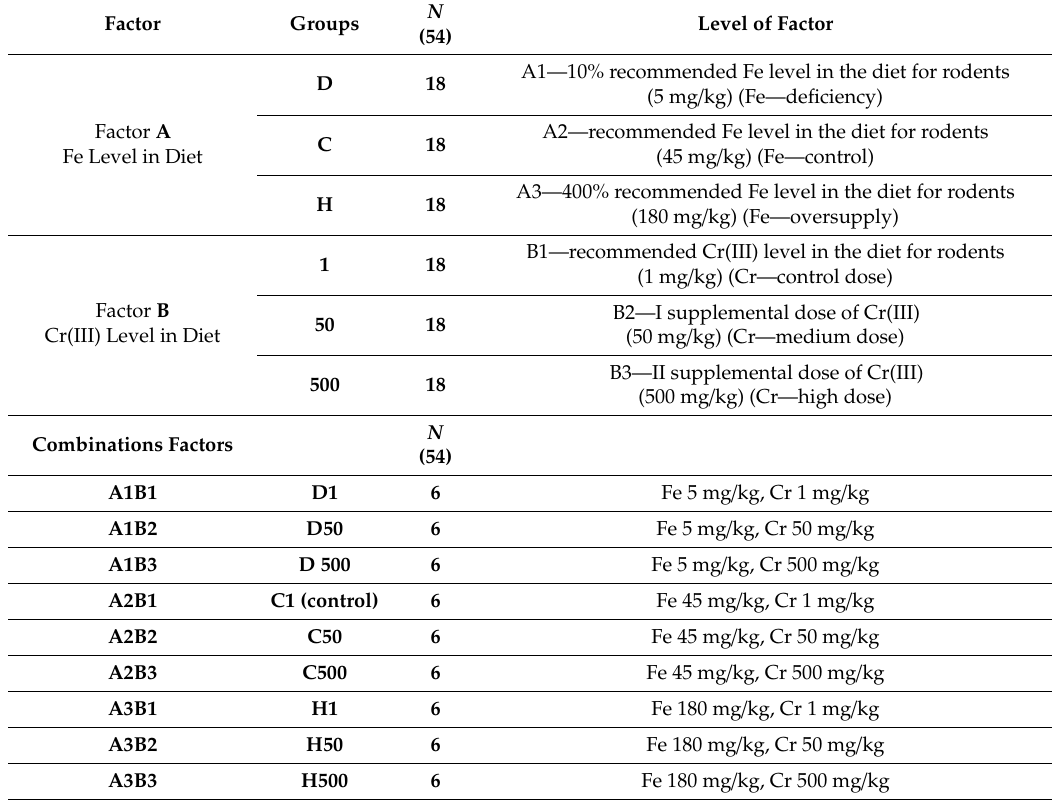
Table 2. Model of the